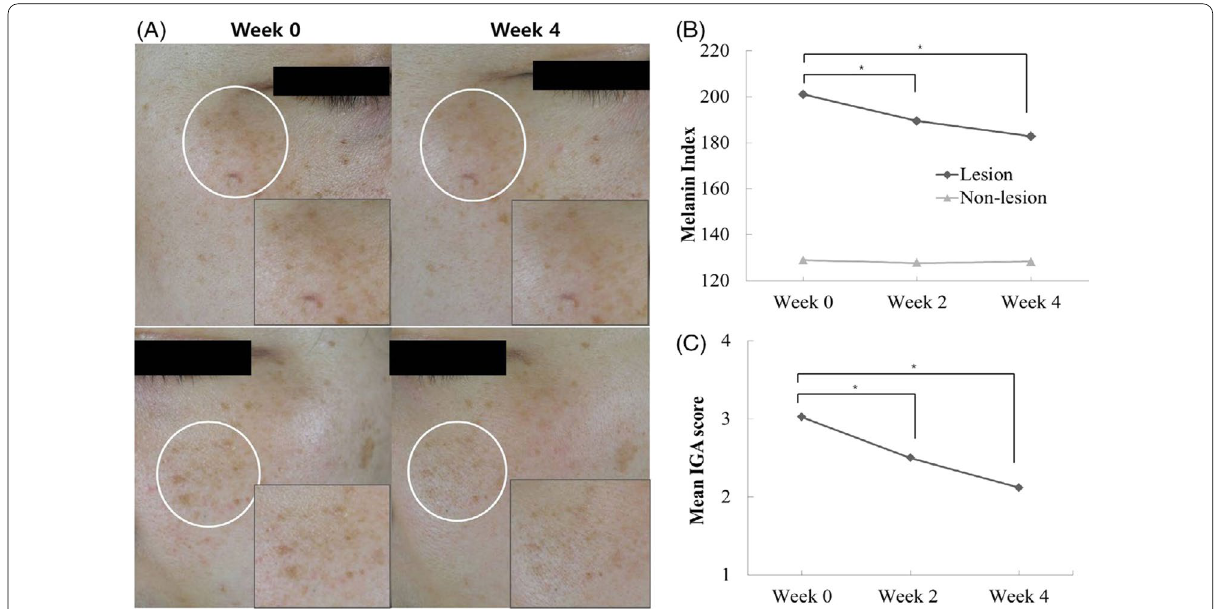
Fig. 5 A Photograph of a patient who showed a good response to the treatment with the 4 ‐ n ‐ butylresorcinol and resveratrol (RSV) cream. B Lesional and non-lesional melanin index (MI) during the 4 ‐ week treatment with the 4 ‐ n ‐ butylresorcinol and RSV cream. The lesional MI at weeks 2 and 4 were significantly decreased compared with the baseline. The non-lesional MI showed no significant change throughout the study (* P < 0.05). C Mean IGA score during the treatment. Reprinted under permission from John Wiley and Sons